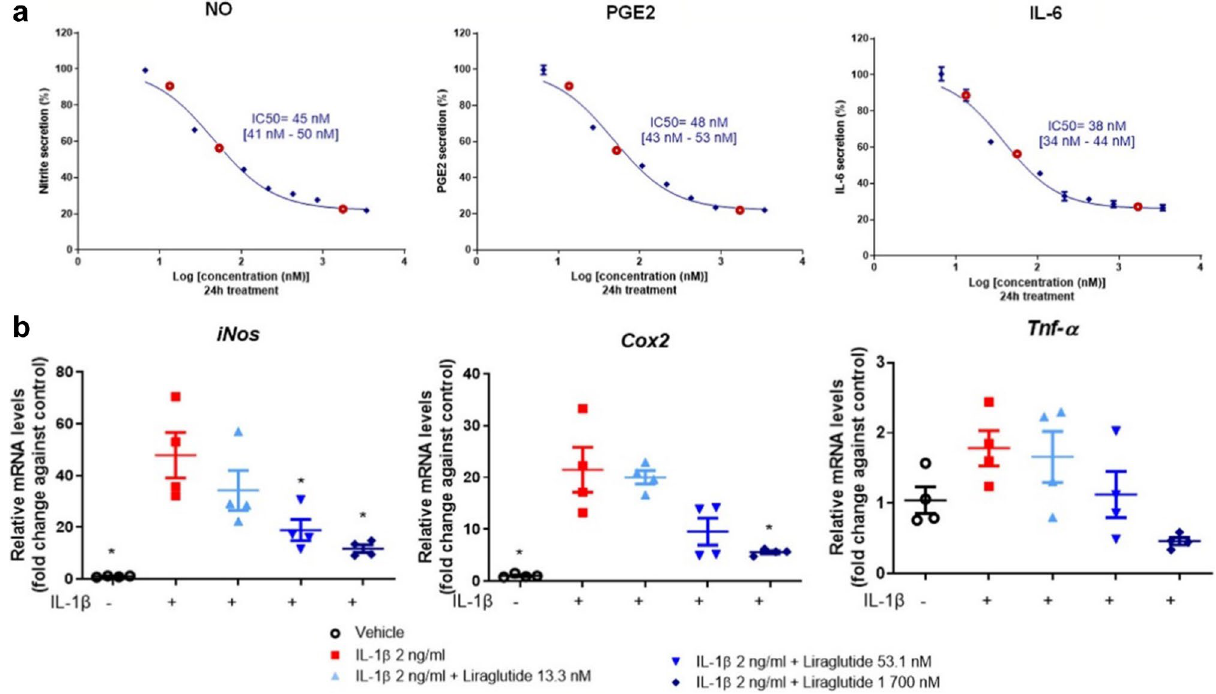
Figure 4. Anti-inflammatory effects of liraglutide in murine primary chondrocytes. Murine primary chondrocytes were stimulated with IL-1β (2 ng/mL) and co-treated with 10 doses of liraglutide (6.6, 13.3, 26.6, 53.1, 106.3, 212.5, 425, 850 nM, 1.7 and 3.4 µM) for 24 h (n = 4). ( a ) The inhibition rate of liraglutide in murine primary chondrocytes was analyzed using GraphPad Prism 9.0, and the IC 50 values were determined for NO, PGE 2 , and IL-6, which were detected in the culture supernatant. ( b ) Relative mRNA expression of iNos , Cox2 , and Tnf-α in murine primary chondrocytes co-treated for 24 h with 2 ng/mL IL-1β and liraglutide (13.3 nM, 53.1 nM, and 1 700 nM, shown in red circles in ( a )) or vehicle (n = 4). Statistical analysis: Mean ± SEM, Mann– Whitney test with sequential strategy, * p < 0.05, versus stimulated control (IL-1β Immunohistochemical assay indicated positive GLP-1R staining at the membrane and intracellular levels in both chondrocytes and RAW 264.7 murine macrophage cell lines by immunofluorescence (Suppl. Fig. 2). Therefore, these two cell models were used to examine the potential anti-inflammatory effect of liraglutide. Liraglutide exerts dose‑dependent anti‑inflammatory effect on murine primary chondro‑ cytes. To investigate the in vitro effect of liraglutide on the production of inflammatory mediators in chon- drocytes, cells were cultured with 2 ng/mL IL-1β for 24 h. IL-1β-induced chondrocytes were incubated with 10 ascending doses (6.6, 13.3, 26.6, 53.1, 106.3, 212.5, 425, 850 nM, 1.7 and 3.4 µM) of liraglutide for 24 h to determine the half maximal inhibitory concentration (IC 50 ) of the inflammatory mediators NO, PGE 2 , and IL-6 (Fig. 4a). Three doses were selected for gene expression analyses (13.3 nM, 53.1 nM, and 1700 nM, shown in red circles in Fig. 4a). Lactate dehydrogenase assay (LDH) was performed to confirm the non-cytotoxicity of lira- glutide treatment on primary murine chondrocytes (data not shown). The results showed that IL-1β stimulation induced an increase in the secretion of the three pro-inflammatory mediators. Remarkably, liraglutide treatment significantly reduced IL-1β-induced secretion of nitrite, PGE 2 , and IL-6 in a dose-dependent manner (Fig. 4a). The calculated IC 50 was 45 nM with confidence interval [41–50 nM] for nitrite secretion, 48 nM [43–53 nM] for PGE 2 secretion, and 38 nM [34–44 nM] for IL-6 secretion (Fig. 4a). Similarly, liraglutide treatment significantly decreased IL-1β-induced expression of iNos, Cox2 and Tnf-α in chondrocytes ( p = 0.0286 compared to IL-1β group) (Fig. 4b, Supplemental Table 1). Overall, these results demonstrated that liraglutide induced broad anti- inflammatory dose-dependent effects in IL-1β-stimulated murine chondrocytes. Liraglutide exerts dose‑dependent anti‑inflammatory effect on murine macrophages. Con- sidering the central role of macrophages in OA and the expression of GLP-1R in the macrophage cell line (Suppl. Fig. 2), the anti-inflammatory effect of liraglutide on RAW 264.7 cell line was examined. RAW 264.7 cells were cultured with 100 ng/mL of LPS at 10 ascending doses (6.6, 13.3, 26.6, 53.1, 106.3, 212.5, 425, 850 nM, 1.7 and 3.4 µM) of liraglutide for 24 h to determine the IC 50 of the pro-inflammatory mediators NO, PGE 2 , and IL-6 (Fig. 5a). Lactate dehydrogenase assay (LDH) was performed to confirm the non-cytotoxicity of liraglutide treatment in a murine macrophage cell line (data not shown). The results indicated that liraglutide treatment significantly reduced LPS-induced secretion of NO, PGE 2 , and IL-6 in RAW 264.7 cells in a concentration- dependent manner (Fig. 5a). The calculated IC 50 was 38 nM with confidence interval [34–44 nM] for nitrite